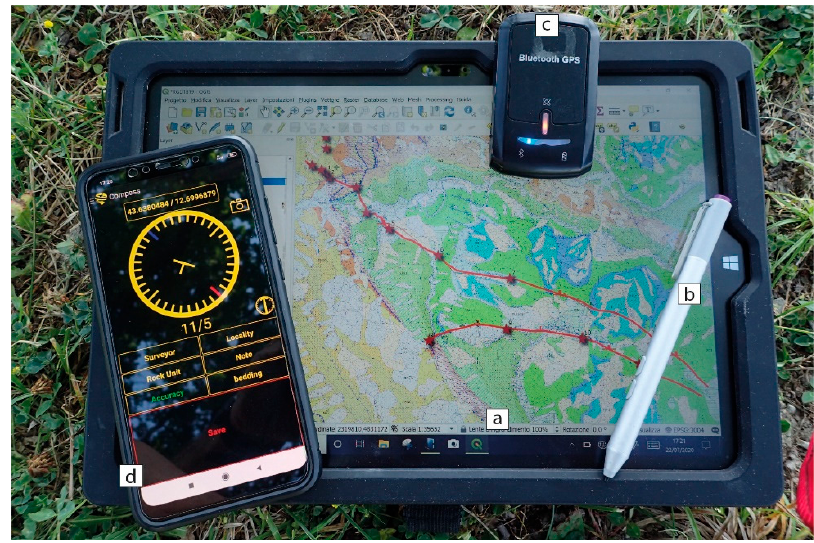
Figure 4. Digital field mapping tools: ( a ) Surface Pro tablet PC; ( b ) Bluetooth stylus; ( c ) Bluetooth GPS antenna; ( d ) Android smartphone.